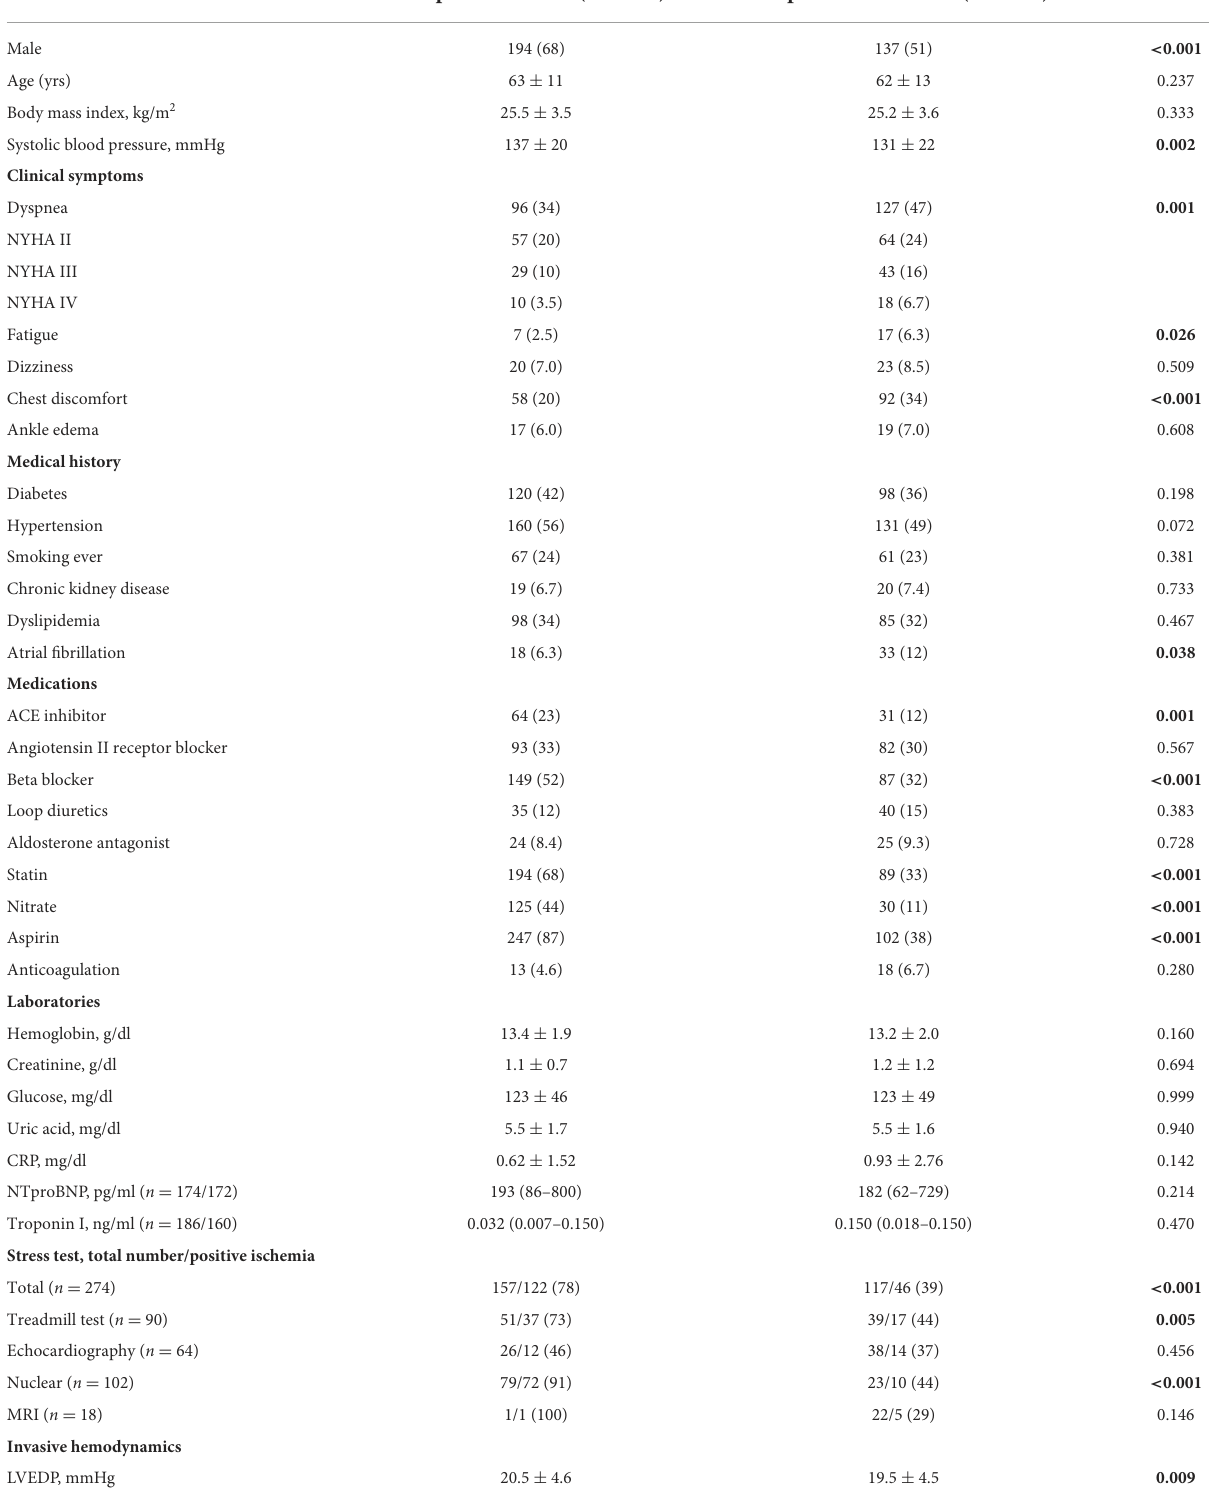
TABLE 1 Baseline